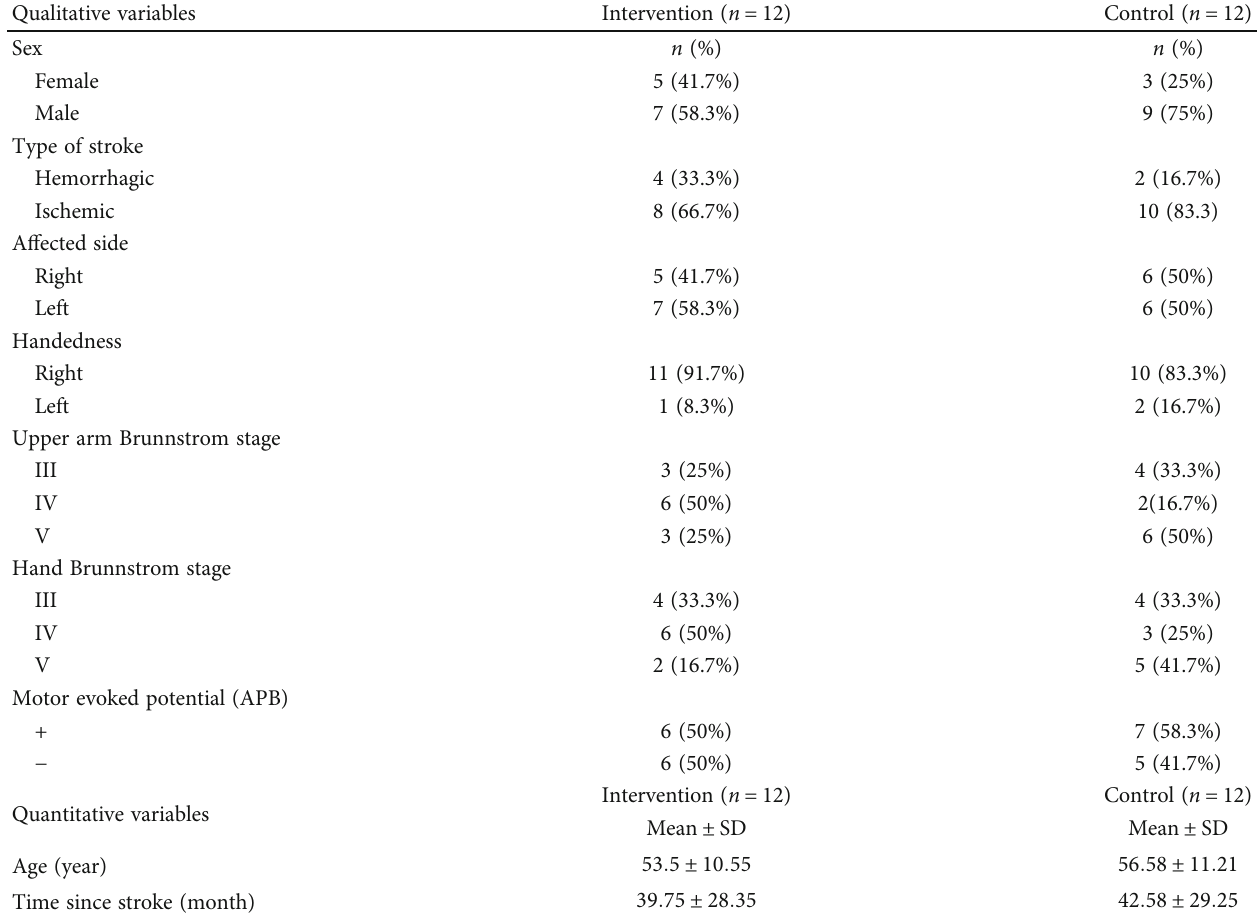
Table 2: Distribution of demographic variables in the intervention and control groups.